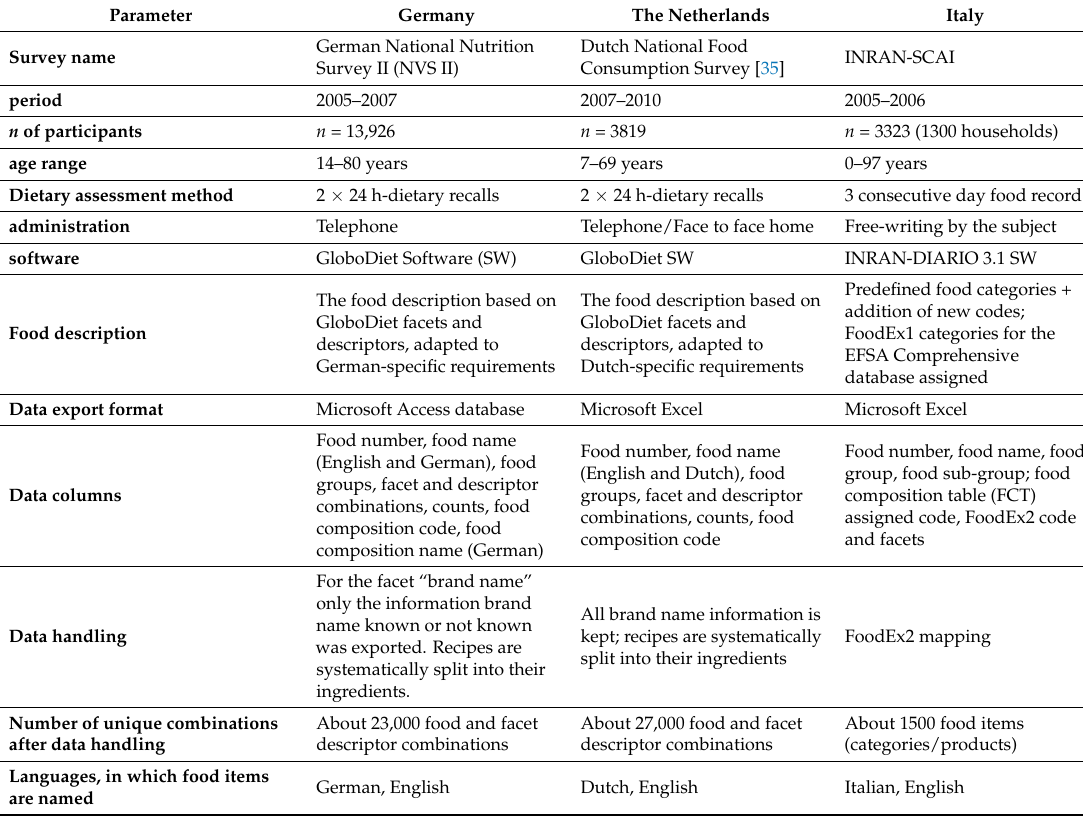
Table 1. Testing datasets of manually matched food consumption and food composition